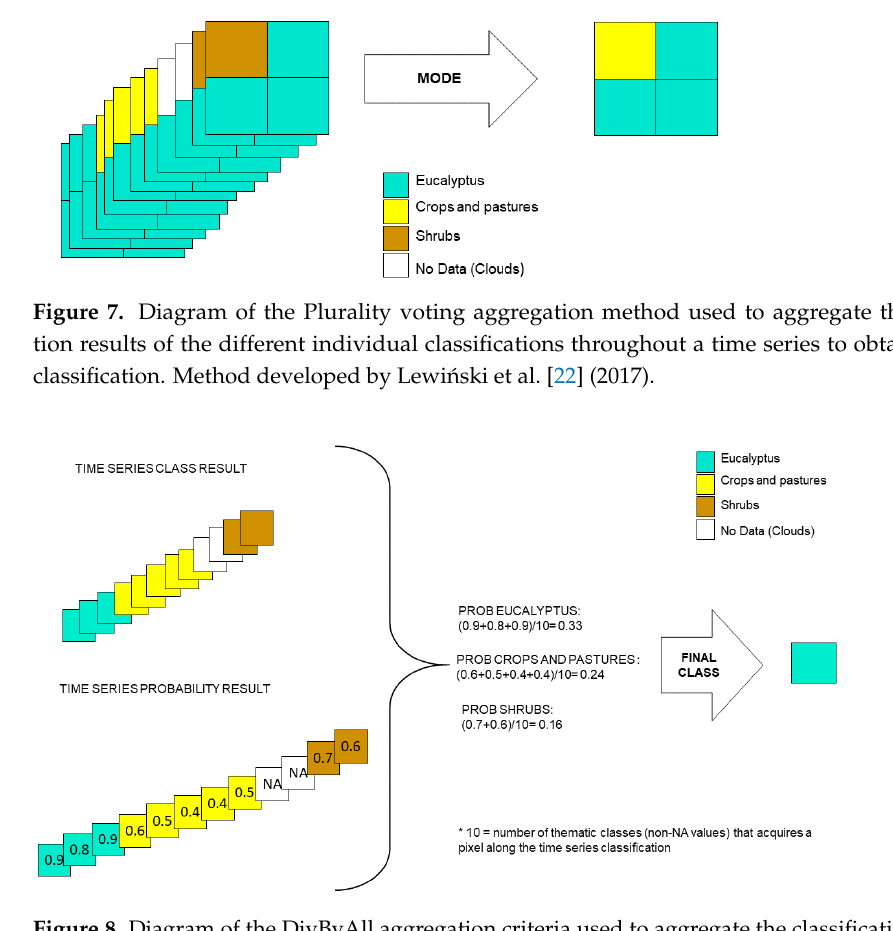
Figure 8. Diagram of the DivByAll aggregation criteria used to aggregate the classification results of each individual image in the time series to obtain a final classification. Adaptation from Lewi´nski et al. [22] (2017).